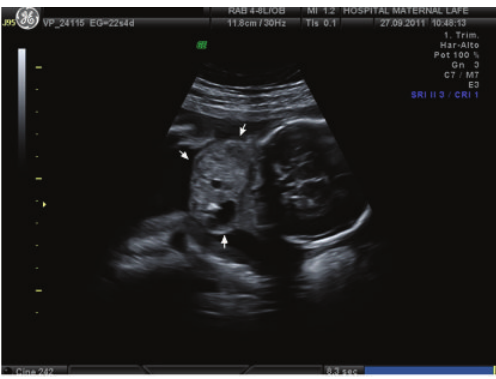
Figure 3: 3D ultrasound.